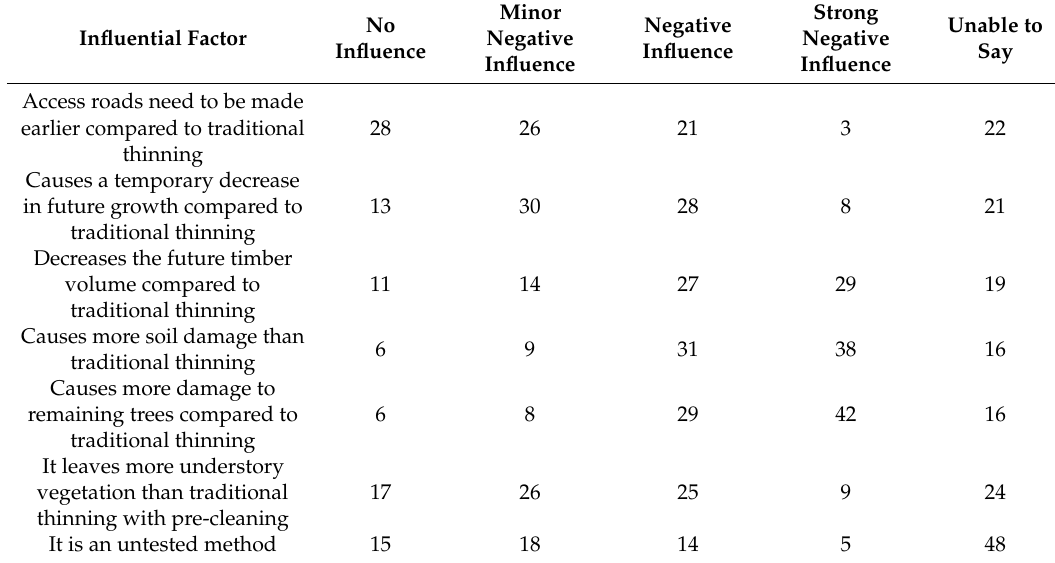
Table 11. Distribution (%) of forest owners’ perception of how various hypothetical disadvantages associated with whole-tree harvesting in early thinnings would a ff ect their attitude towards the method.